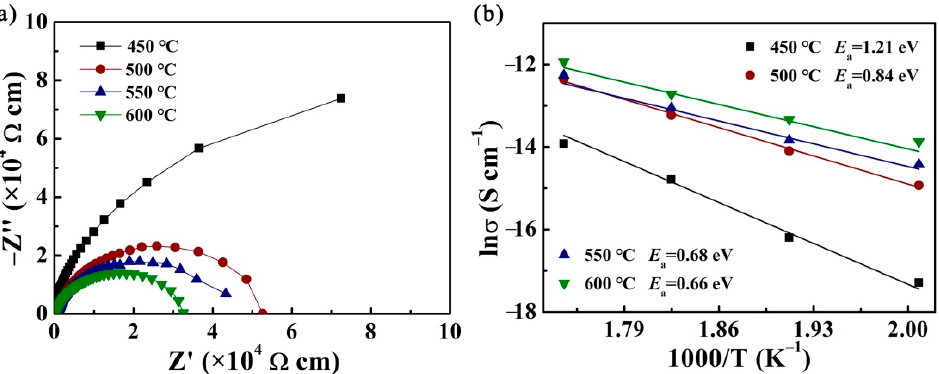
Figure 5. ( a ) The impedance and fit result of CBTi-BFO films measured at 300 °C. ( b ) Arrhenius plots of CBTi-BFO films annealing at different temperatures. of CBTi-BFO films annealing at different